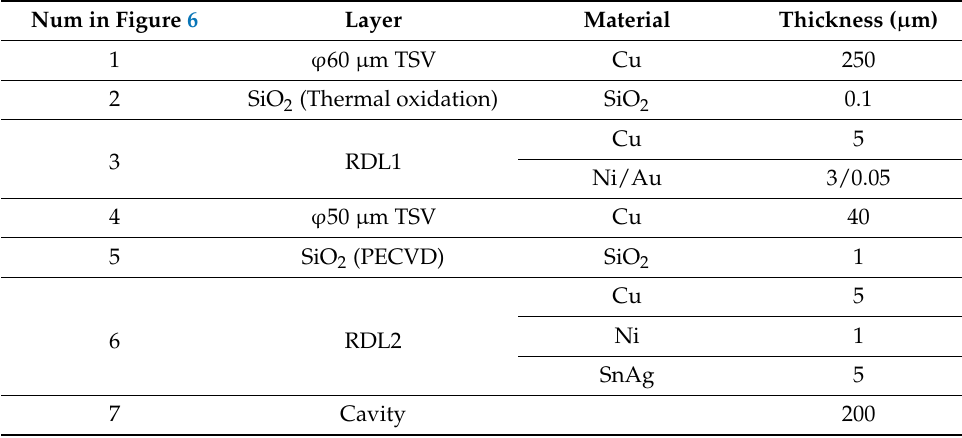
Figure 7. The SEM images of the cap wafer. ( a ) conformal-plated TSVs, ( b ) cavities. Table 2. Process parameters of the cap interposer wafer.